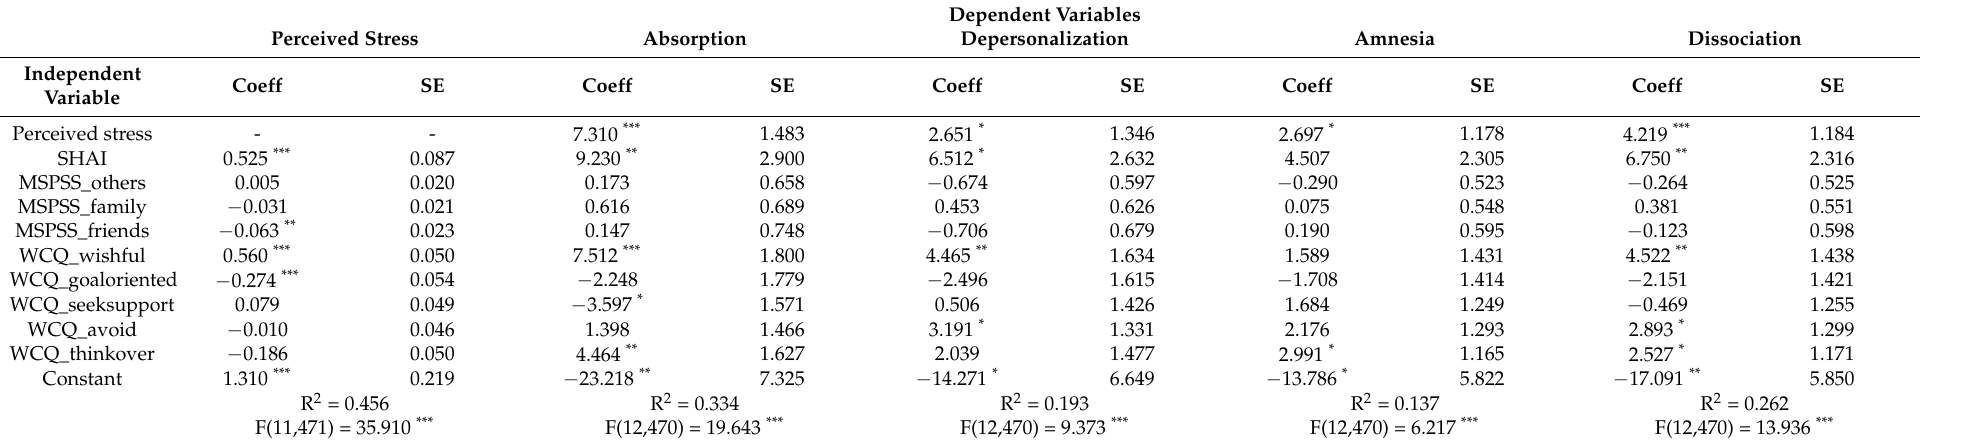
Table 9. Coefficients of the linear regression of the International